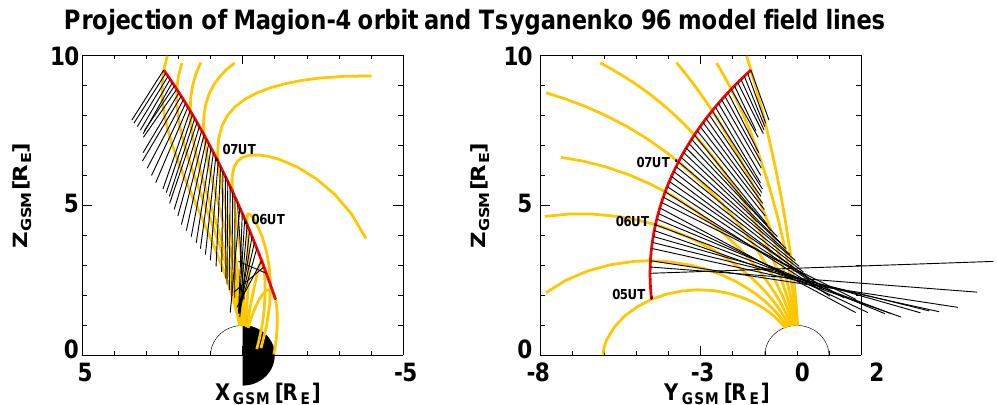
Fig. 5. Projections of the MAGION-4 orbit into the X-Z (left part) and Y-Z (right part) planes according to the Tsyganenko model. The abscissas show the magnetic field vector as measured by MAGION-4 each 5 min.